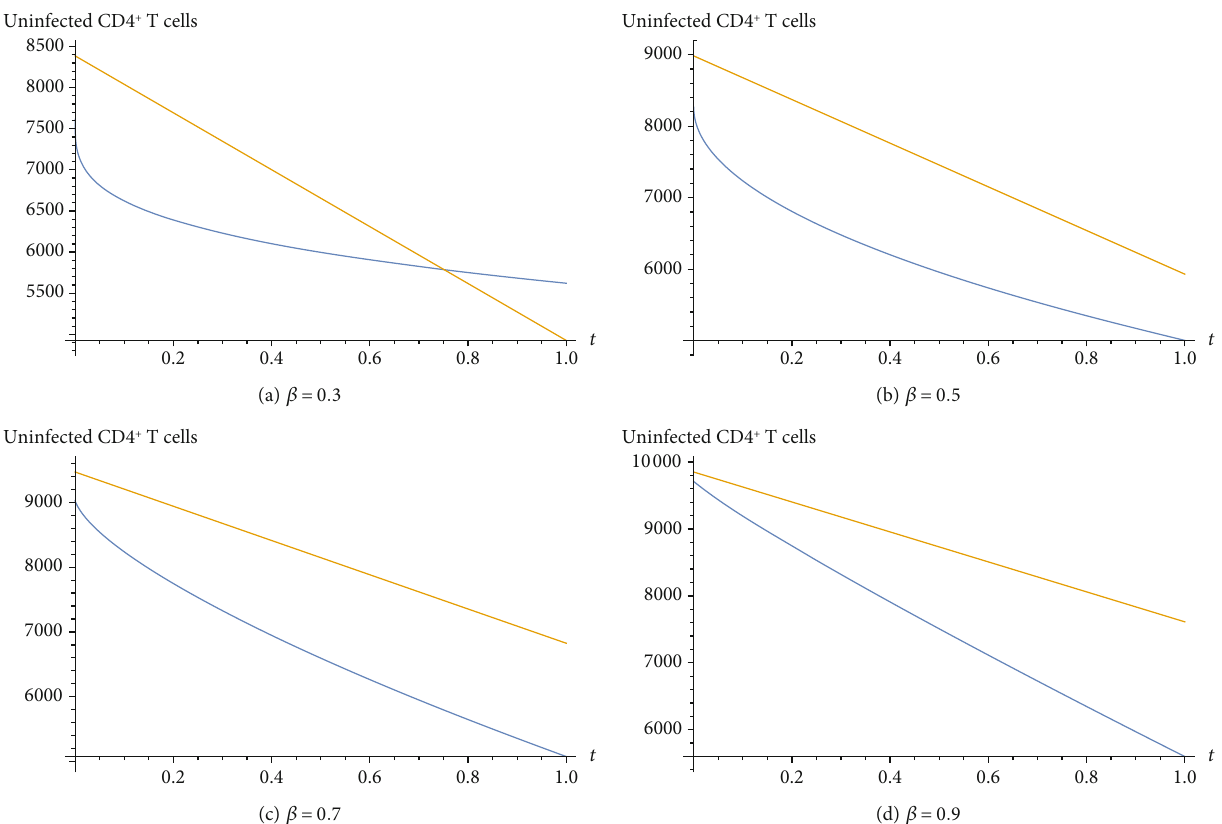
Figure 3: The comparison of the behavior of uninfected CD4 + T cells in Caputo-Fabrizio and Atangana Baleanu sense for di ff erent order fractional derivatives, where blue colour represents graph for ABC operator and orange represents graph for CF